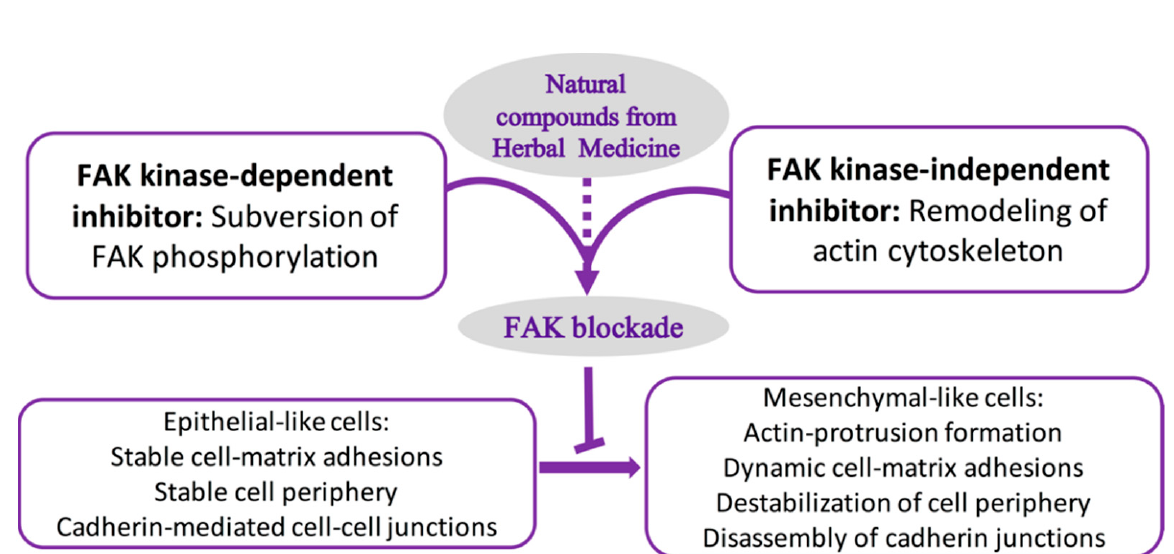
Figure 2. Potential FAK inhibitors from natural sources.